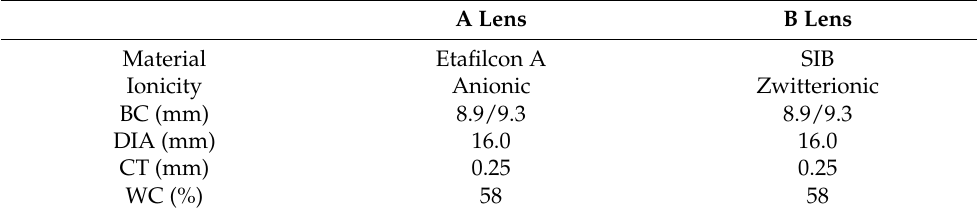
Table 1. Overview of key criteria of both